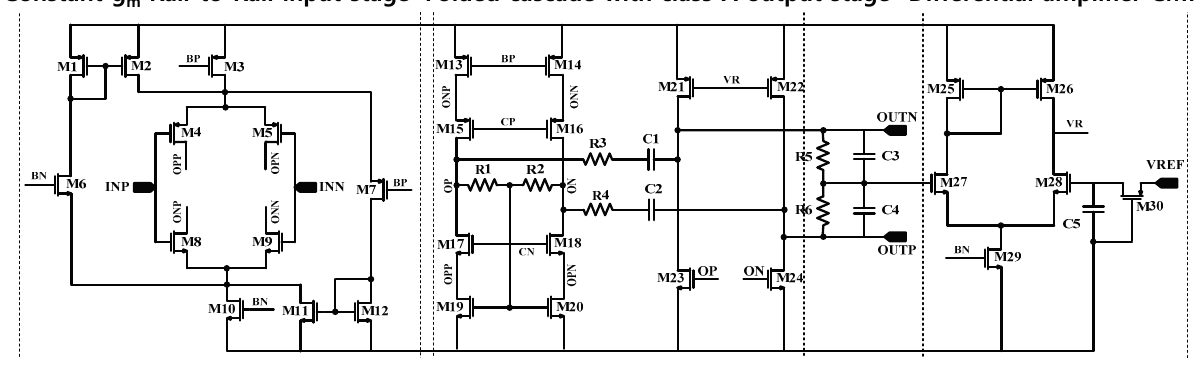
Figure 3. Schematic of proposed core